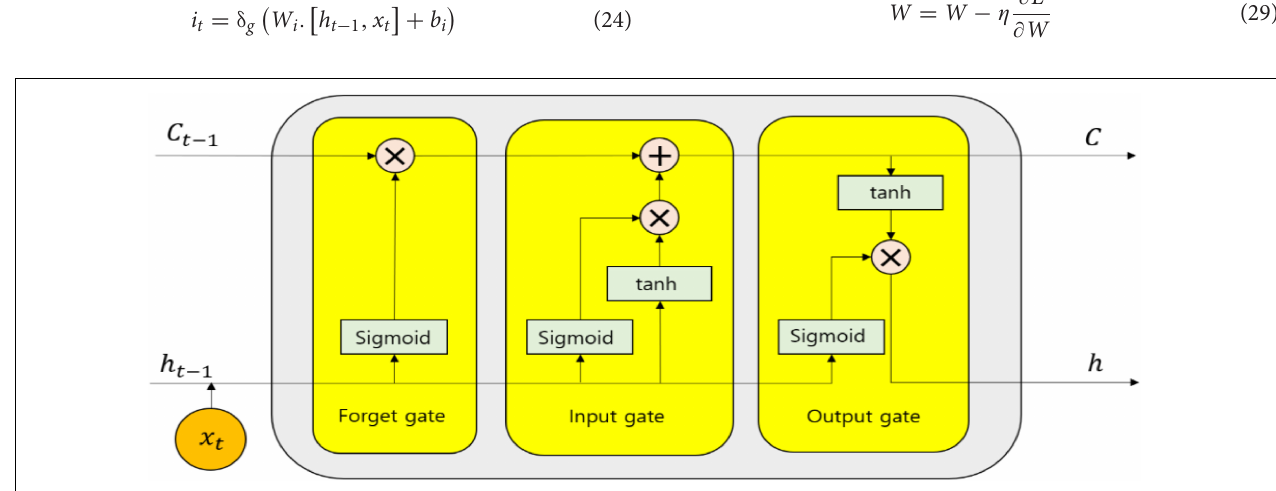
FIGURE 3 | Simple representation of an Long Short-Term Memory (LSTM)